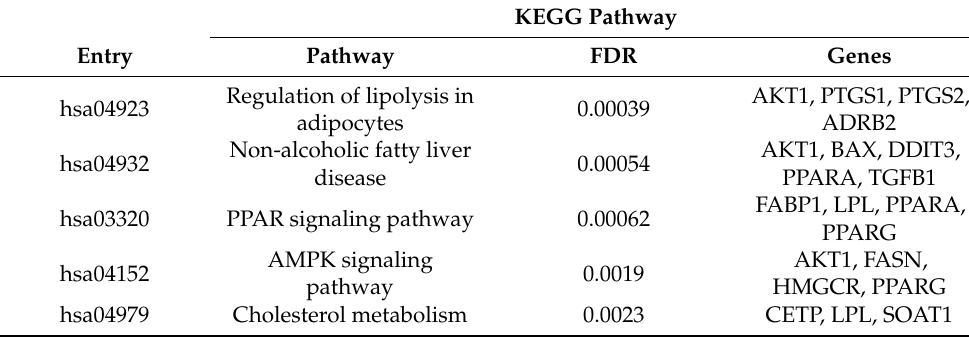
Table 3. Enriched KEGG pathway obtained from DAVID